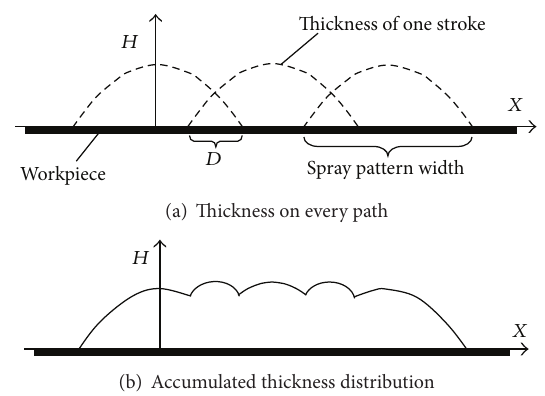
Figure 3: Coating thickness distribution of painting